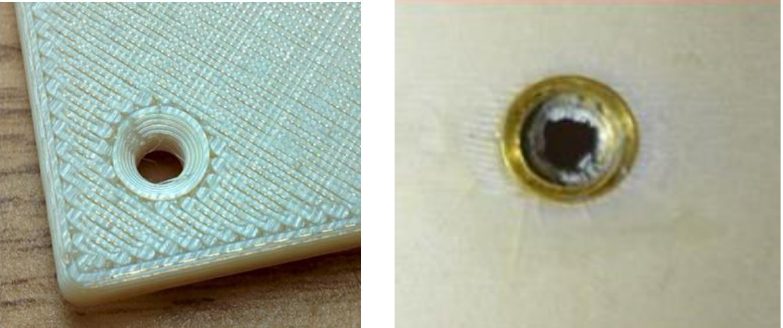
Figure 7. The threaded insert ( left , avionics box) and radial cracks around it ( right , specimen) [51]. Credit: NASA.